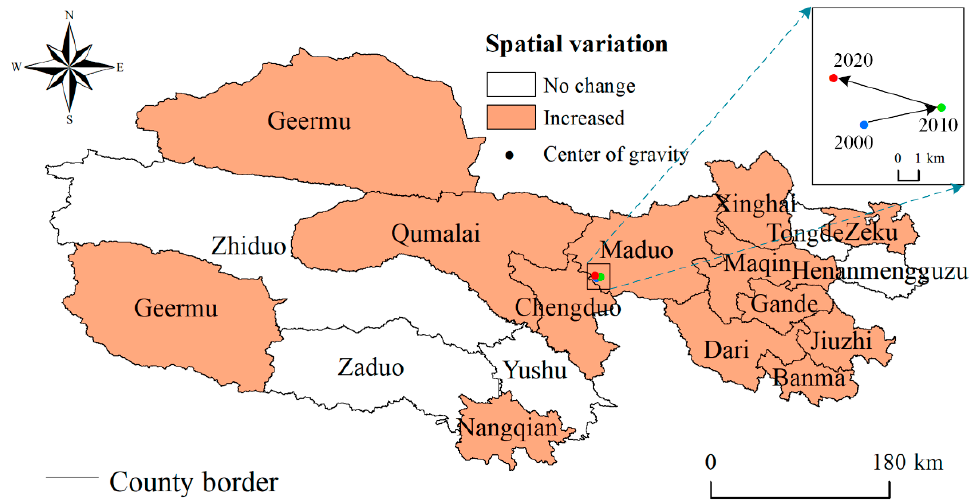
Figure 9. Spatial changes and shifts in the center of gravity of the spiritual and cultural index (SCI) in the Sanjiangyuan area during 2000–2020.